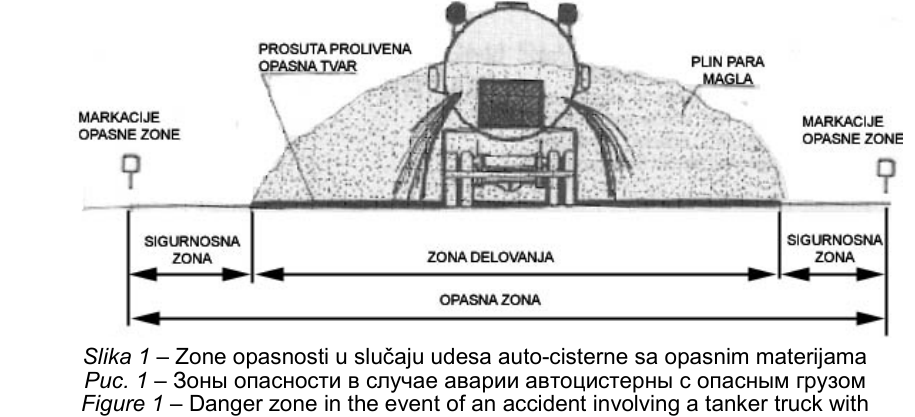
Figure 1 – Danger zone in the event of an accident involving a tanker truck with hazardous